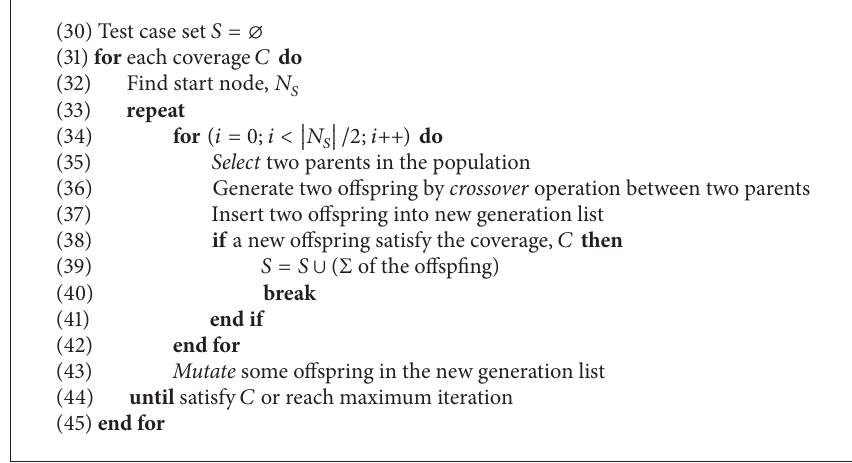
Algorithm 3: Pseudocode of genetic